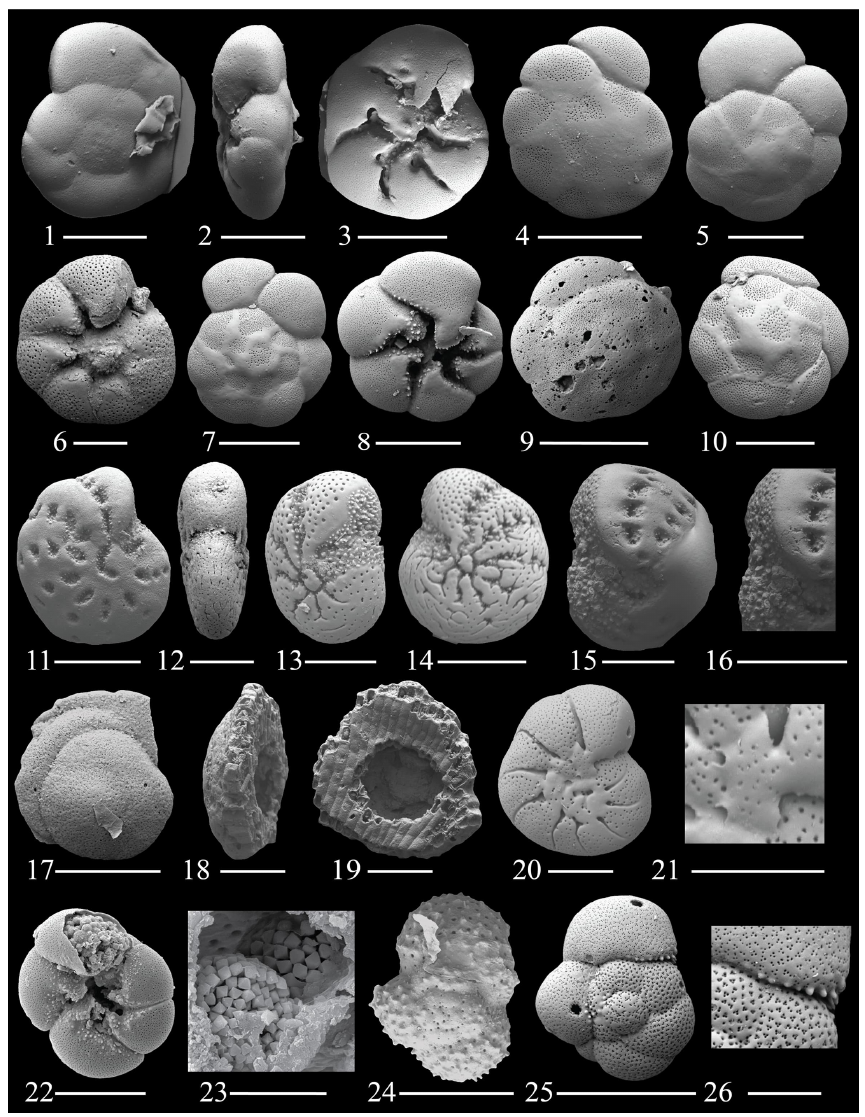
Figure 9. (1–3) Ammonia advena Cushman; (4–10) Ammonia veneta (Schultze); (11–14) Cribroelphidium mirum Langer and Schmidt- Sinns; (15–16) Elphidium sagrum (d’Orbingy); (17–19) Discorbis willamsoni Chapman and Parr; (20–21) Astrononion gallowayi Loeblich and Tappan; (22–23) Pyrite framboids found in our specimens, (24) Globigerinoides sp. 1; (25–26) Globigerinoides sp. 2. The scale bar is 100 and 50µm for figs. (6) , (13) , (15) – (16) , and (18) – (20) , 25µm for figs. (21) and (26) , and 10µm for fig. (23)